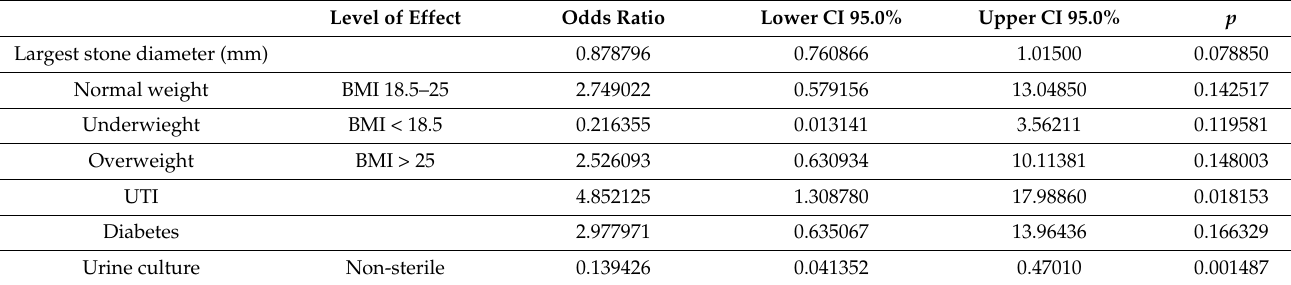
Table 4. Parameters affecting occurrence of